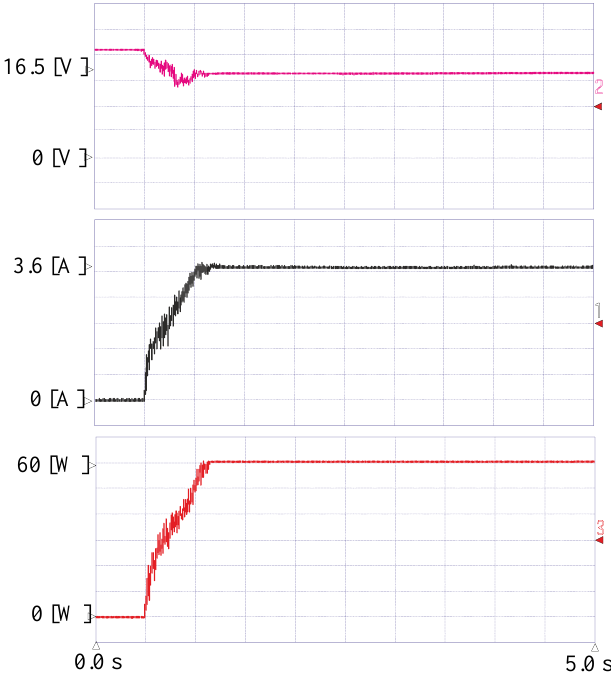
Figure 17. Experimental results of SA-P&O MPPT considering case 1.